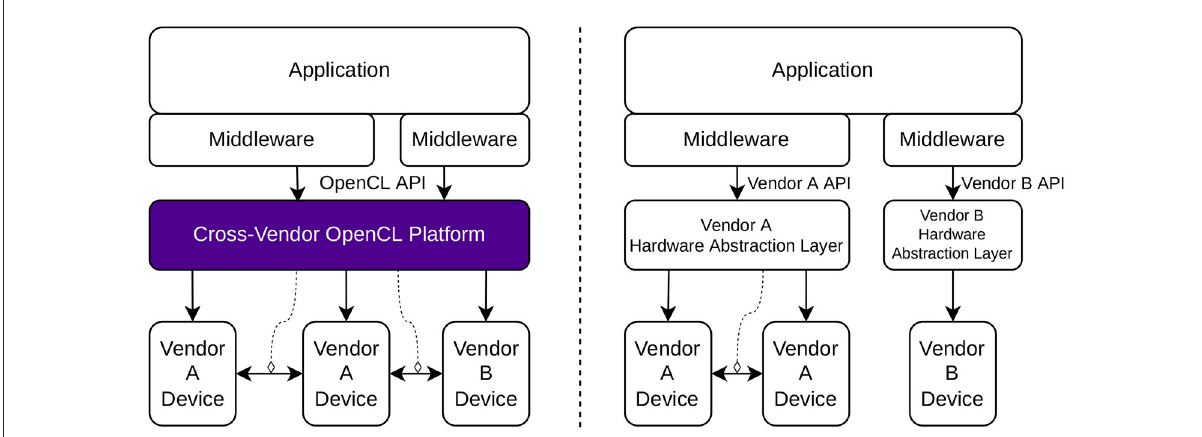
FIGURE2 (Left) Proposed method of controlling various hardware devices with a common OpenCL platform. (Right) Current status of the field with multiple vendor-specific hardware abstraction layers. The vertical arrows correspond to the control commands being passed down the software stack. The horizontal arrows between the devices describe inter-device functionality such as direct memory access and synchronization. The dashed arrows show the management of such inter-device